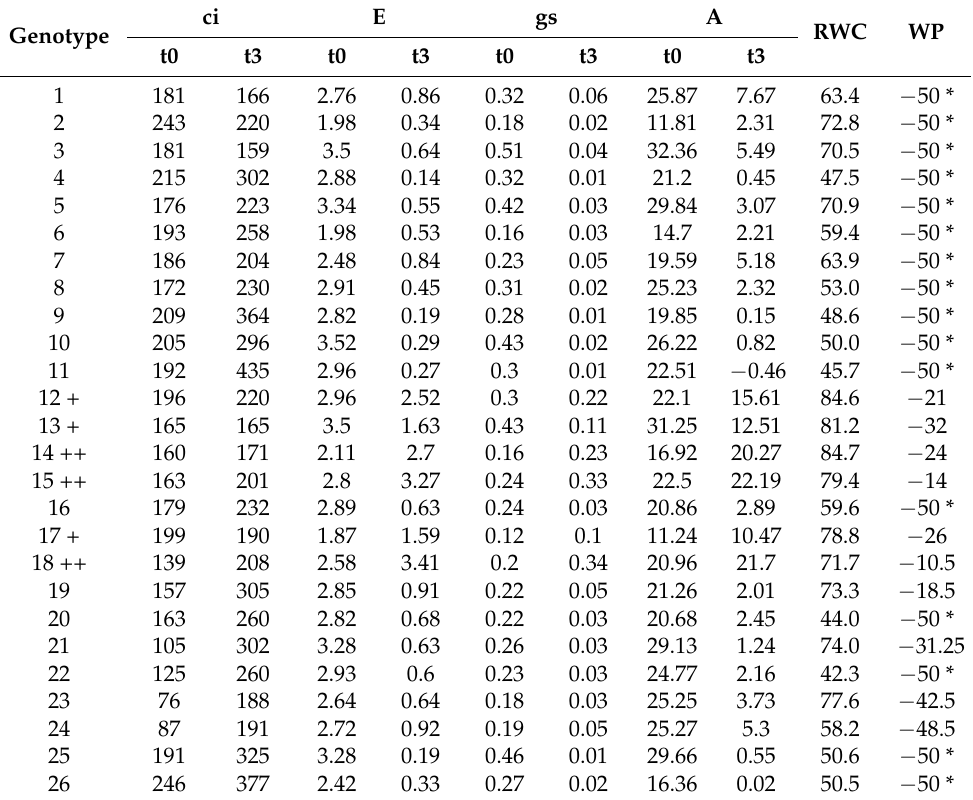
Table 1. Gas exchange related parameters water status of 26 hybrid plants on t0 (control) and t3 (3 weeks under water deficit). Ci—intercellular CO 2 concentration, E—transpiration rate, gs— stomatal conductance, A—net CO 2 assimilation rate, RWC—relative water content, WP—water potential. + plants with an intermediate performance. ++ plants identified with the best